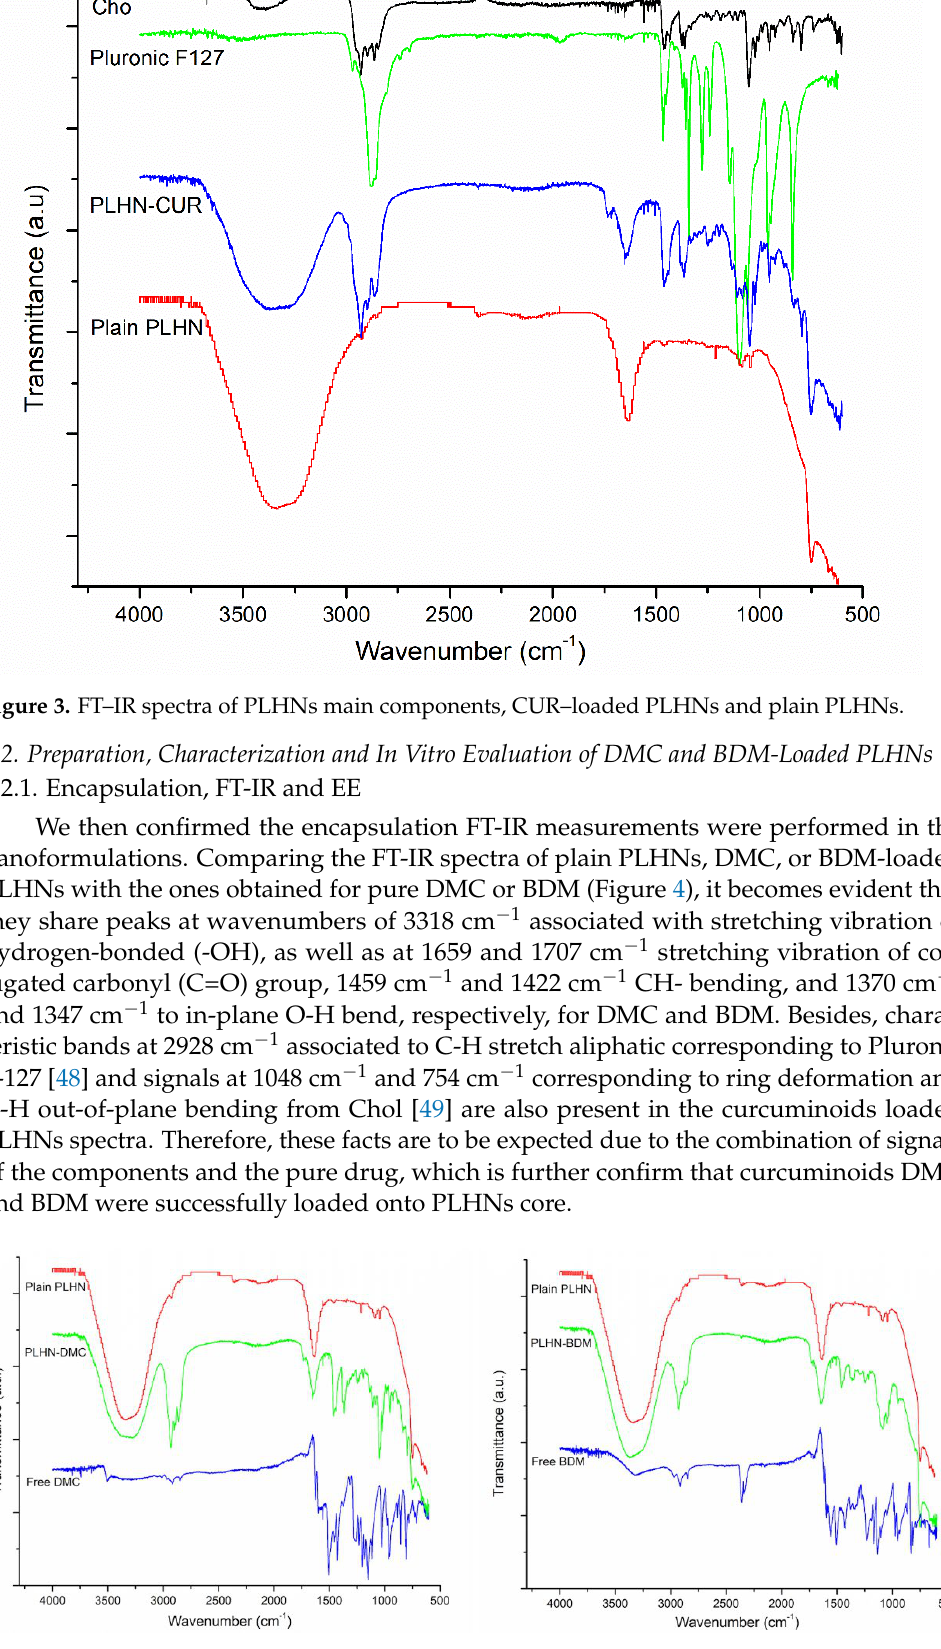
Figure 4. FT–IR spectra of DMC and BDM–loaded PLHNs, plain PLHNs and free DMC and BDM.